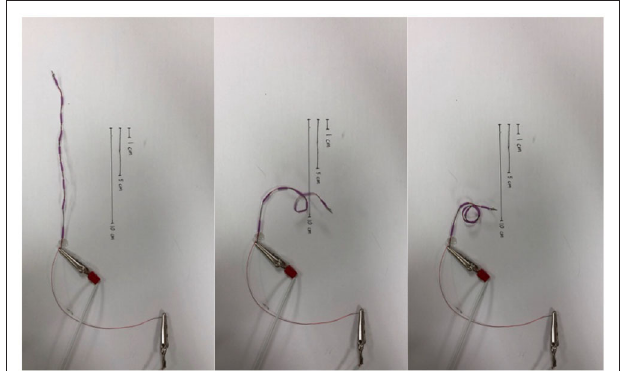
FIGURE 9 | Coiling SMA robotic searcher.